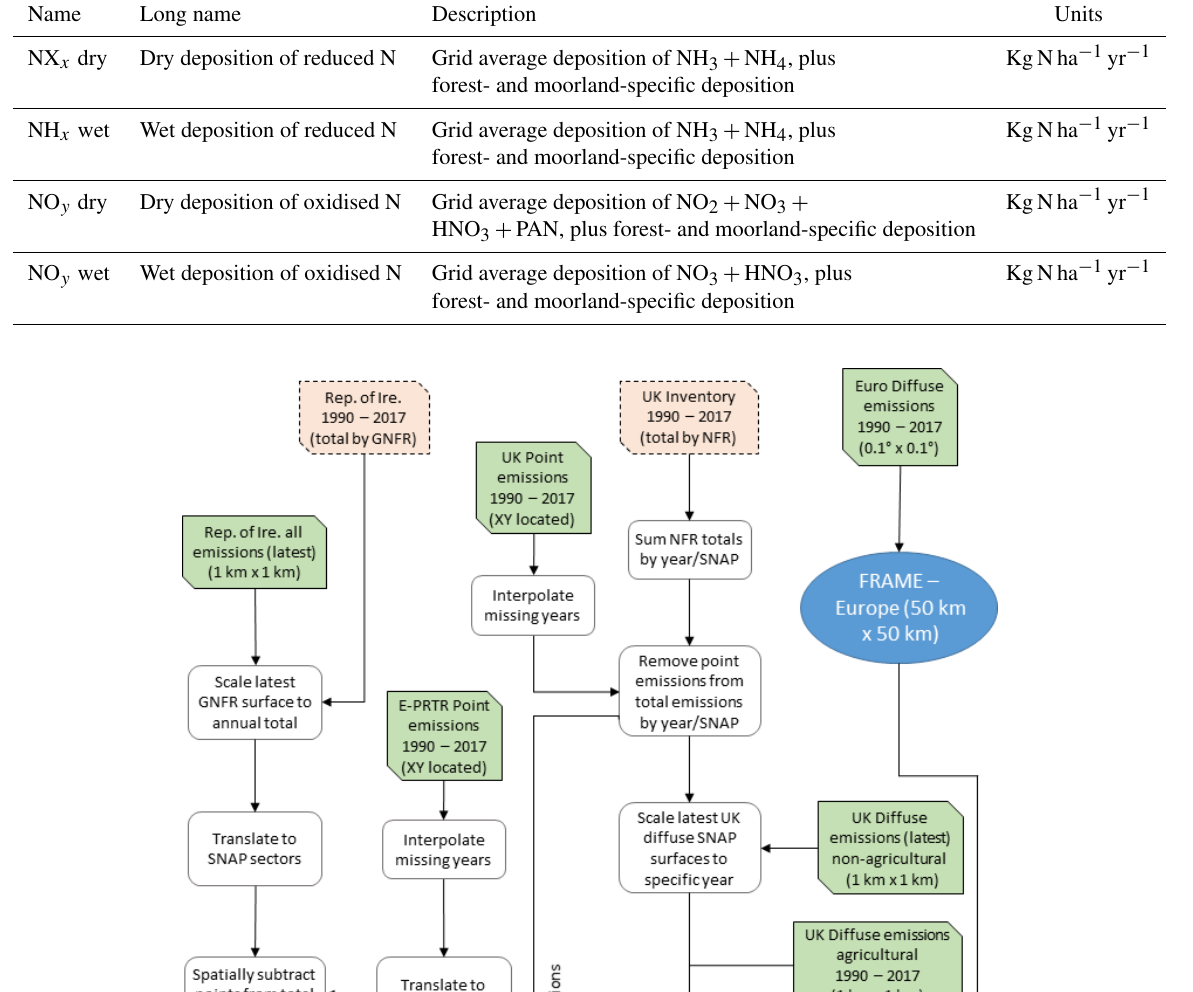
Table 2. Deposition outputs as provided in this dataset from the Fine Resolution Multi-pollutant Exchange (FRAME) atmospheric chemistry transport model.